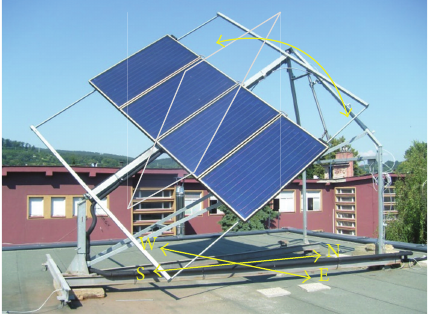
Figure 7: Solar panels installed on a rotary tracking construction copying the path of the